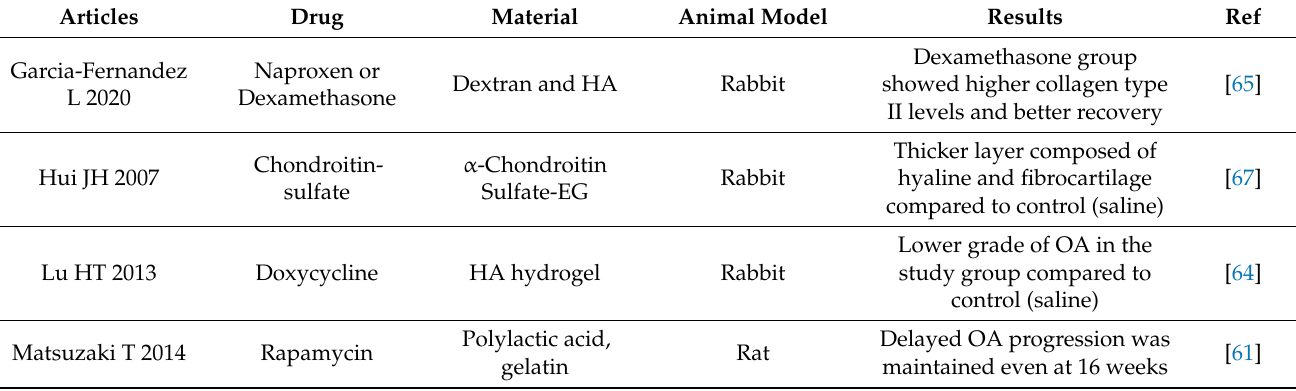
Table 3. Synopsis of studies employing hydrogels. Legend: ADAMTS-5A—disintegrin and metalloproteinase with throm- bospondin motifs 5 2; ADH—adipic acid dihydrazide; CrmA—cytokine response modifier A; DPPC—1,2-dipalmitoyl-sn- glycero-3-phosphocholine; EG—ethyl-glycol; FBR—foreign-body responses; HA—hyaluronic acid; HDI—hexamethylene di- isocyanate; IL—interleukin; MMP—matrix metalloproteinase; NGF—nerve growth factor; OARSI—Osteoarthritis